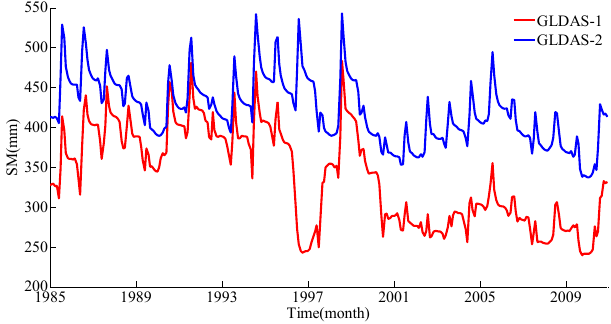
Figure 8. SM of GLDAS-2 and GLDAS-1 over the Liao River Basin from 1985 to 2010.